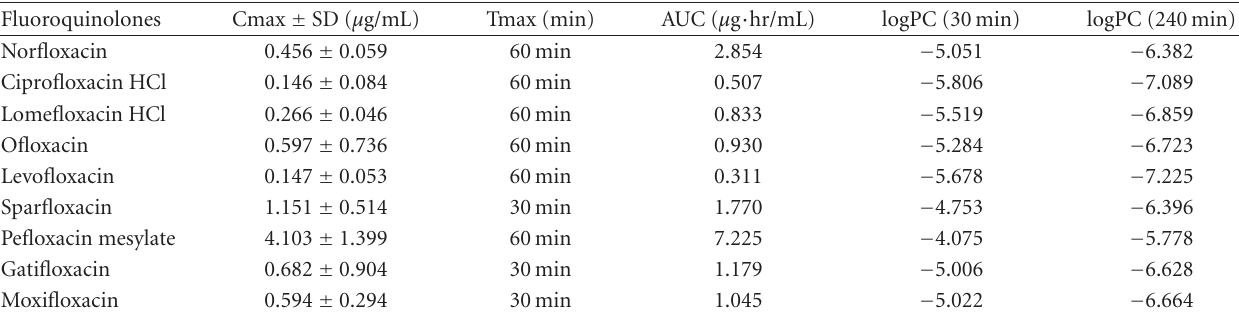
Table 3: Pharmacokinetic parameters derived for all fluoroquinolones using in vivo cassette dosing approach in rabbits.